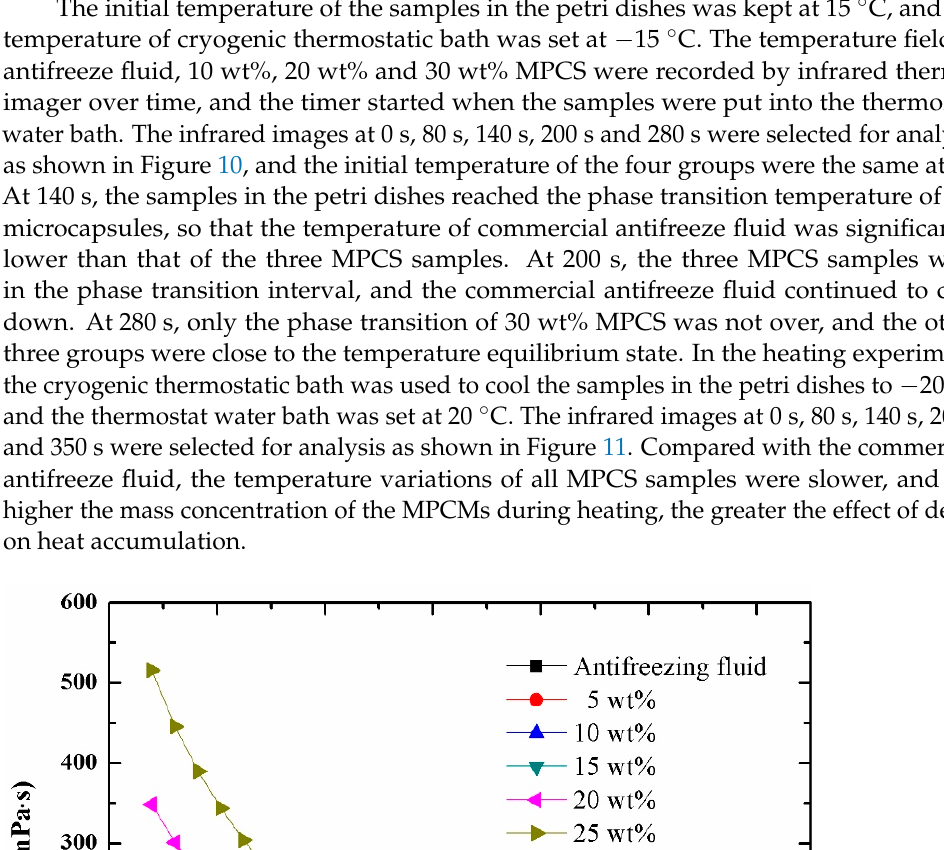
Figure 8. The relationship between shear stress and shear rate of 25 % MPCS at − 25 °C, 0 °C and 25 °C.